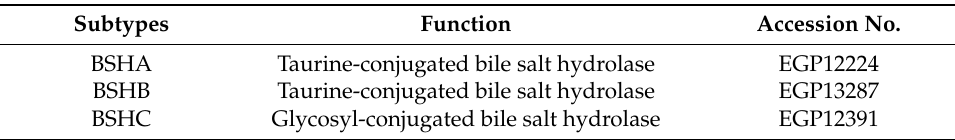
Table 1. Information on the three BSH subtypes from L. johnsonii